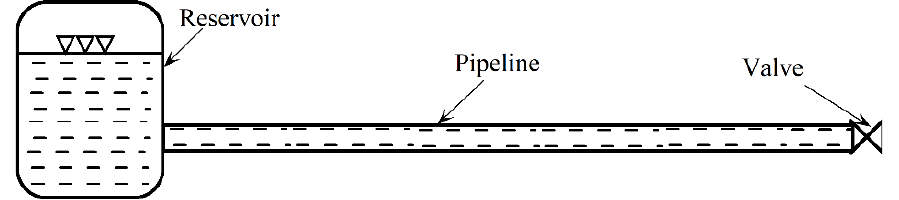
Figure 1. The generalized layout for